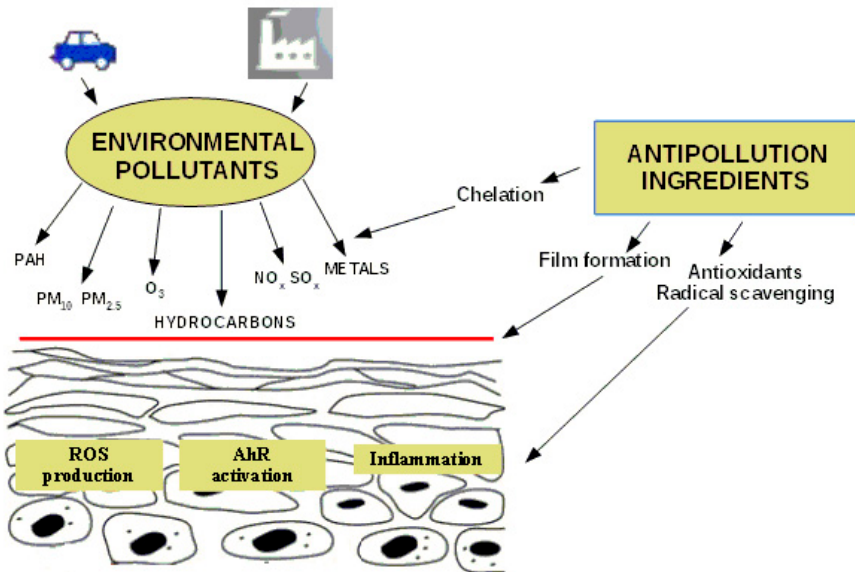
Figure 1. Mechanisms of the effects of environmental pollutants on skin and strategies for anti-pollution skin defense.